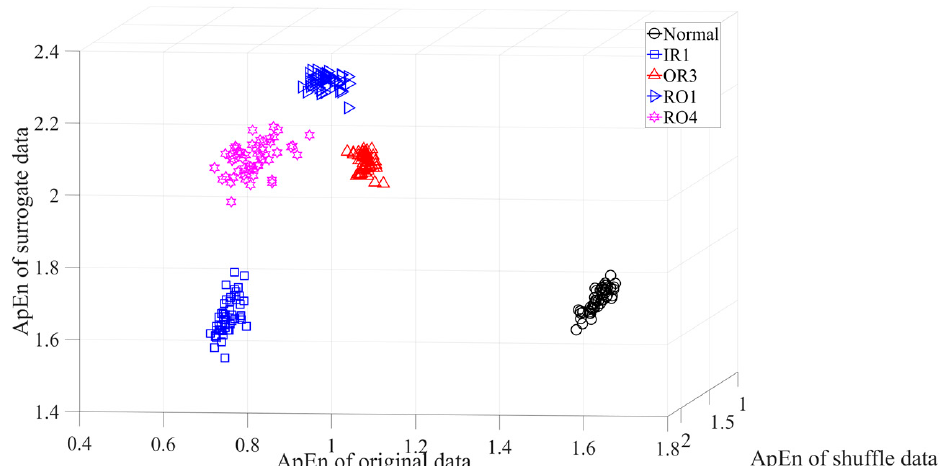
Figure 23. Ternary ApEn of the rolling-bearing vibration data.